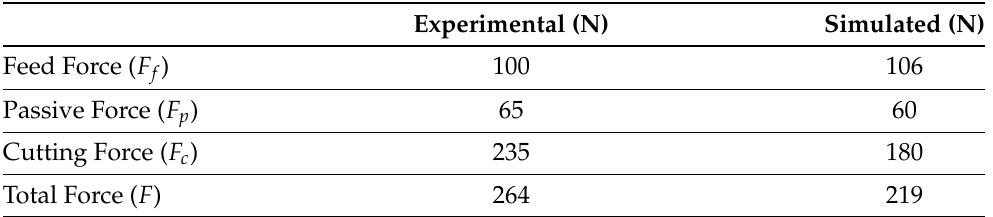
Table 6. Comparison of forces predicted by 3D model with experiments.